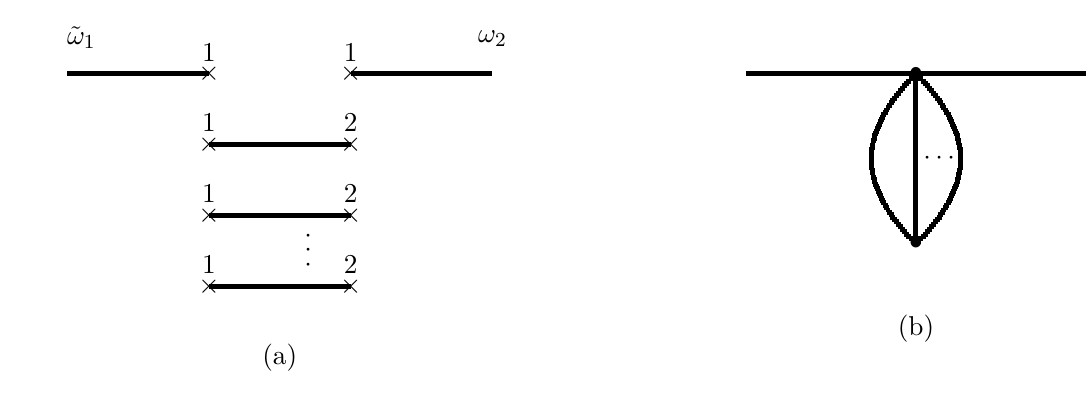
Figure 13 . (a) Examples of Feynman diagrams of open closed string field theory giving part of the leading 2-instanton contribution to the closed string 2-point amplitude. We also have a similar diagram where the pair of 1’s in the top line are replaced by a pair of 2’s. (b) Representation of the same diagram in the closed string effective field theory.